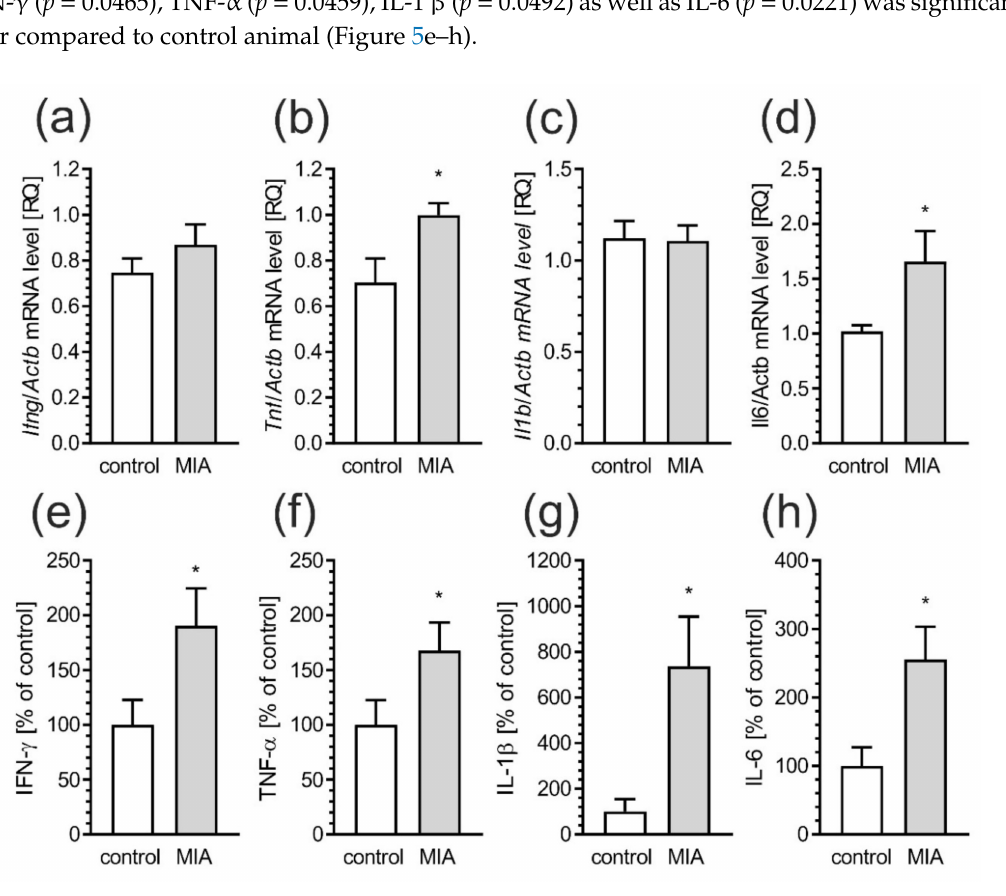
Figure 5. MIA induces neuro-inflammatory responses in blood and brain of o ff spring rats. O ff springmaleratsatPND52–54weresacrificedandbloodandbraintissueswerecollected. ( a – d )E ff ects of prenatal LPS exposure on mRNA for pro-inflammatory proteins in cerebral cortex of o ff spring rats. The mRNA levels were measured by real time-PCR, and normalized to Actb ( β -actin). ( e – h ) E ff ects of prenatal LPS exposure on pro-inflammatory cytokines in blood, as determined by using the Bio-Plex Pro Rat Cytokine 23-Plex Assay. Data represent the mean value ± S.E.M. (a–n = 4, b–n = 4, c–n =